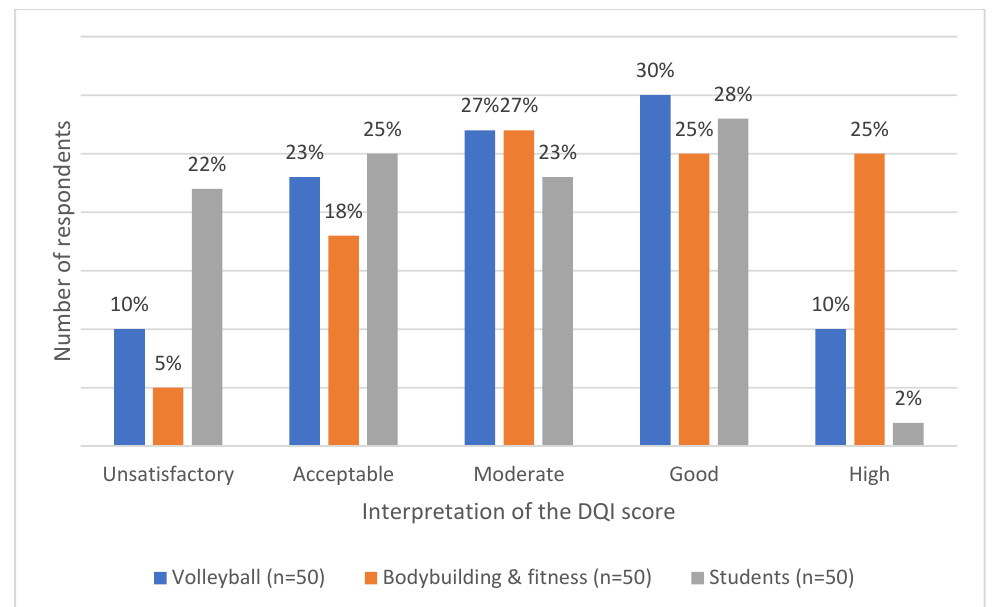
Figure 2. Interpretation of the DQI score.